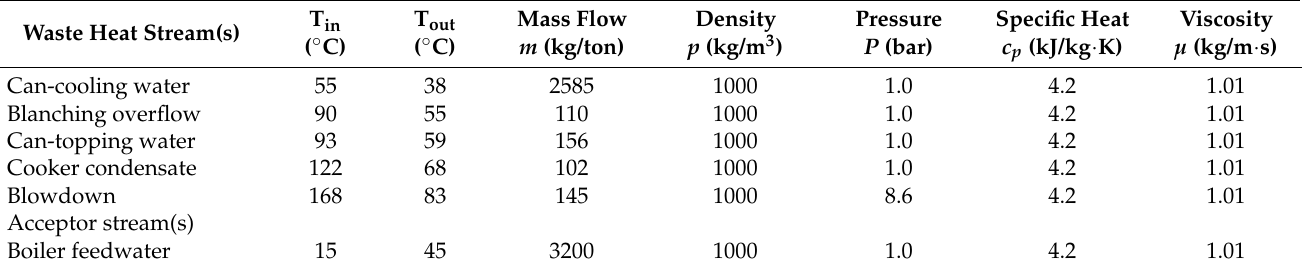
Table 5. Waste heat recovery inventory data for a canned food processing